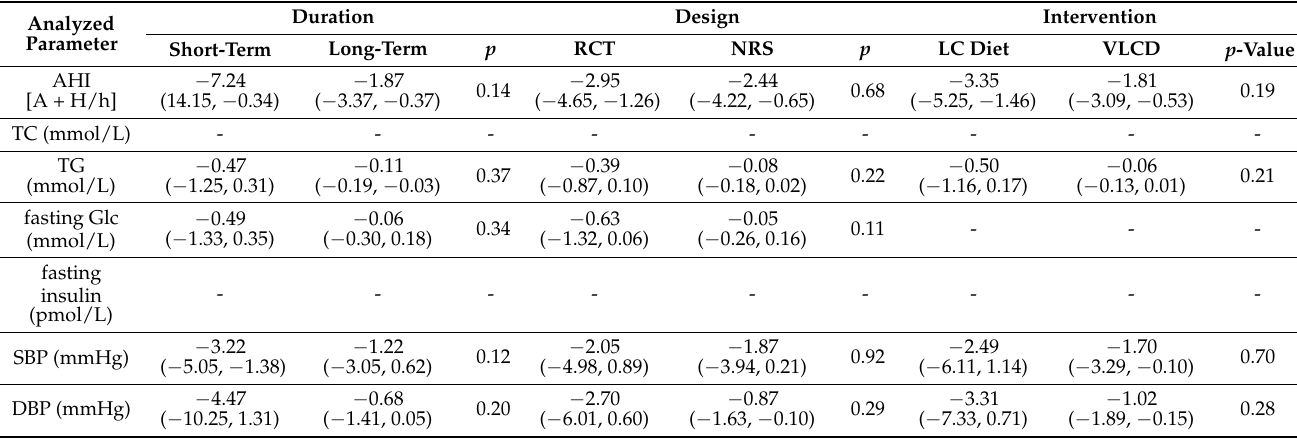
Table 3. Subgroup analyses for possible influences of BMI reduction on AHI and cardio-metabolic risk-factor changes (study duration, study design and type of dietary intervention).